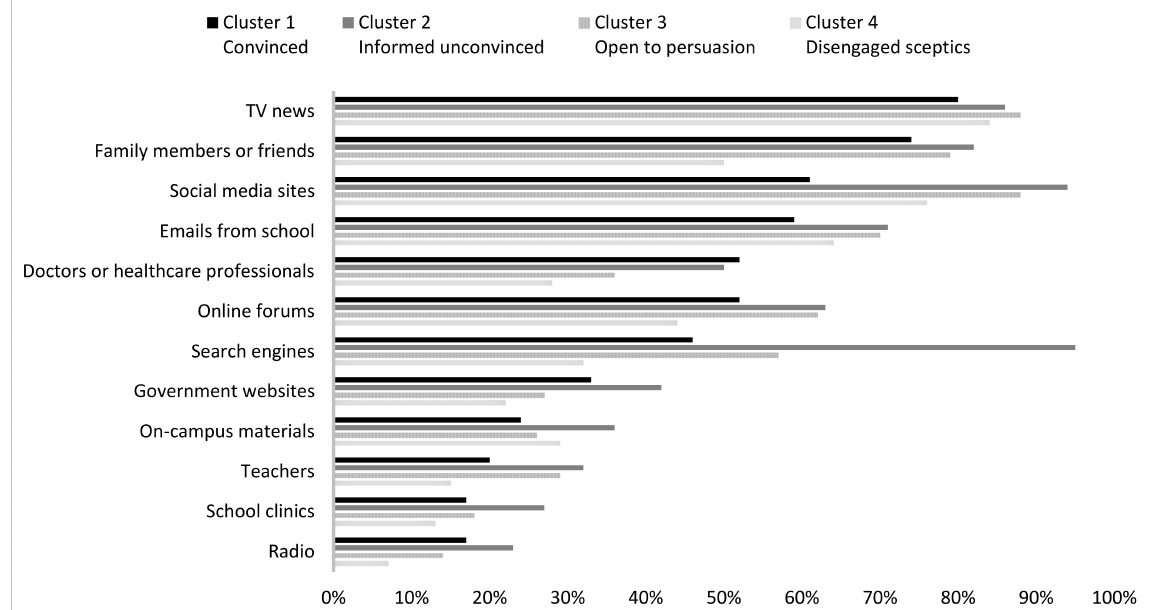
Figure 2. Sources from which most flu-related information was received by